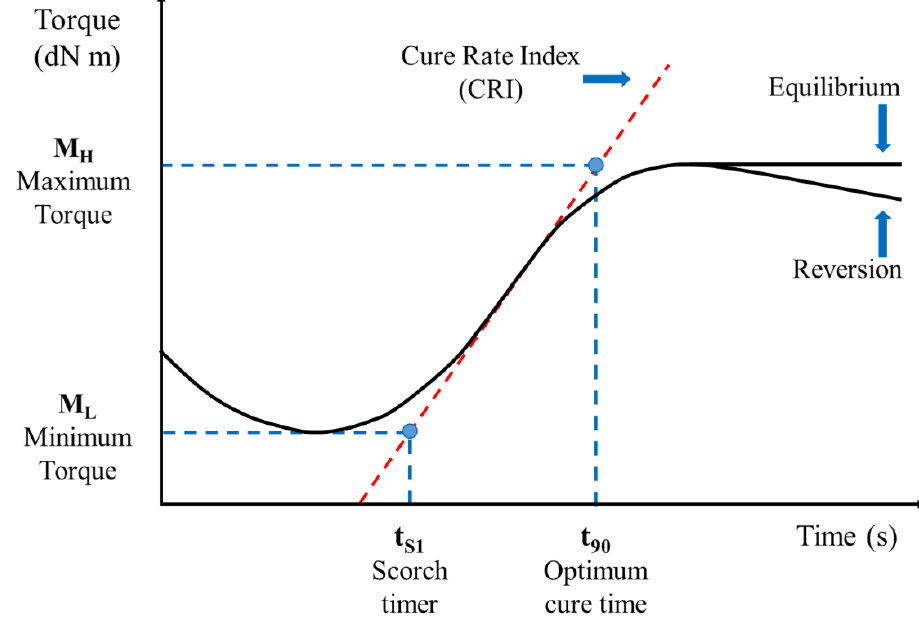
Figure 2. Rheometric curve .